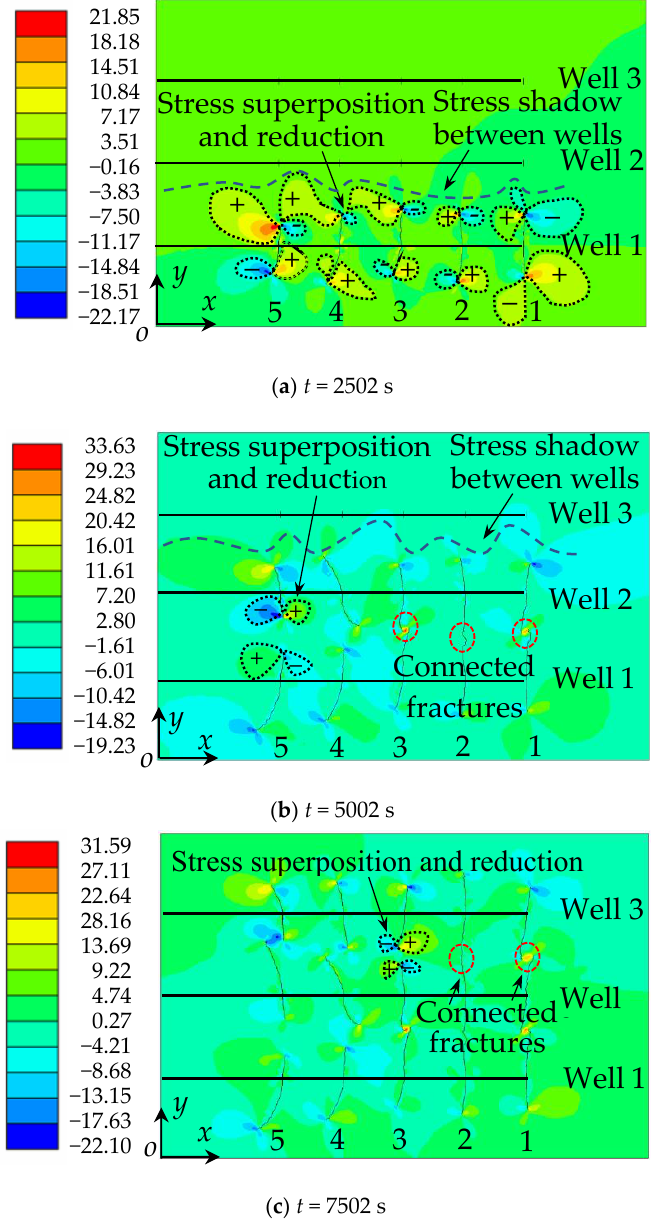
 (Mpa) in sequential fracturing at 100 m well spacing. Figure 8. Evolution of shear stress τ xy (Mpa) in sequential fracturing at 100 m well Figure 8. Evolution of shear stress xy